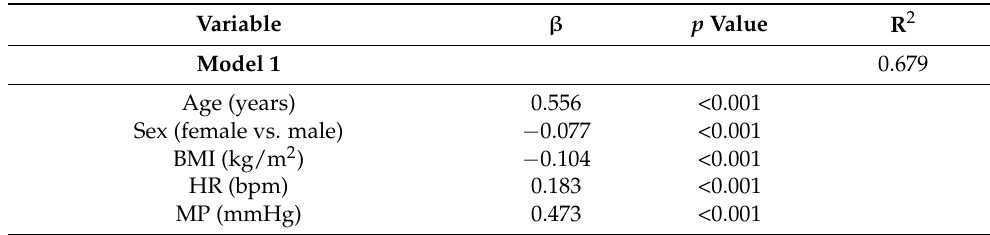
Table 4. Determinants of BAPWV explored using a simple linear regression analysis.